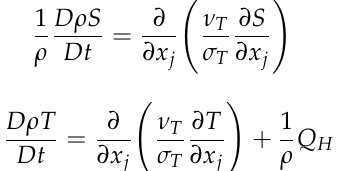
Salinity * (PSU) Min. Max. Min.